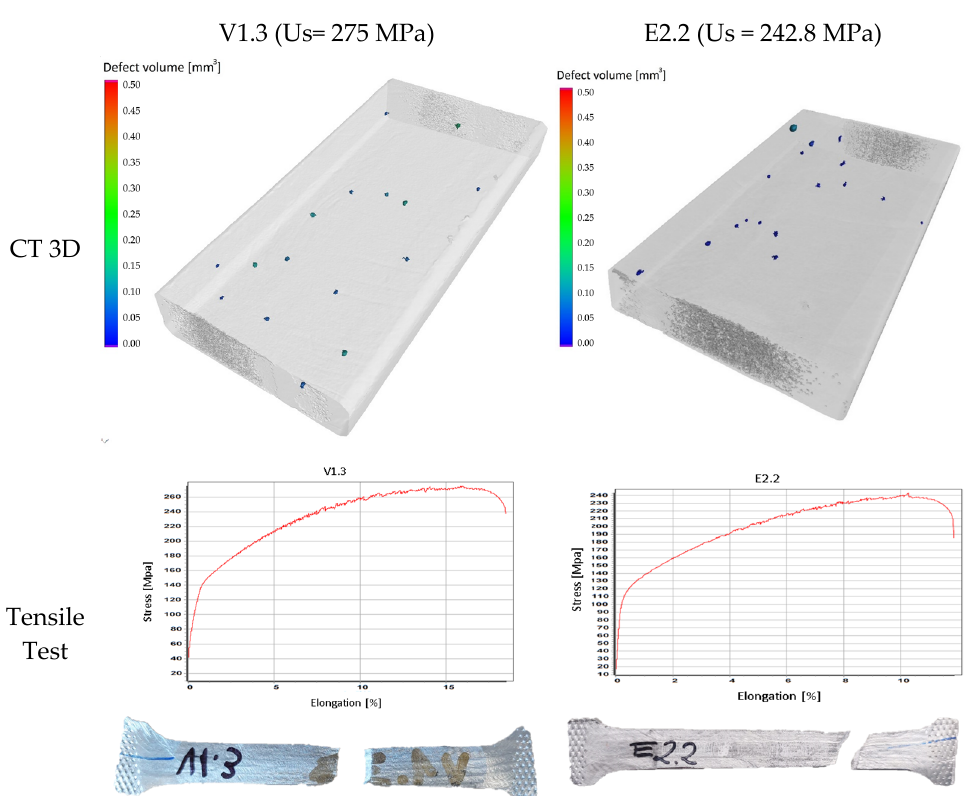
Figure 11. Graphical results of CT and tensile testing of V1.3 and E2.2 specimens.